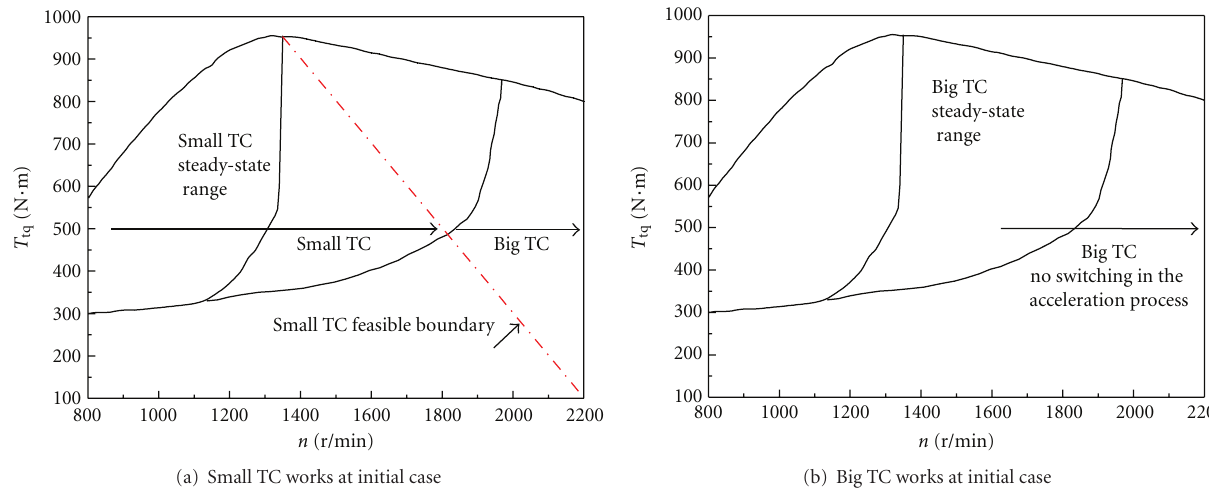
Figure 12: Optimal acceleration switching boundary of the